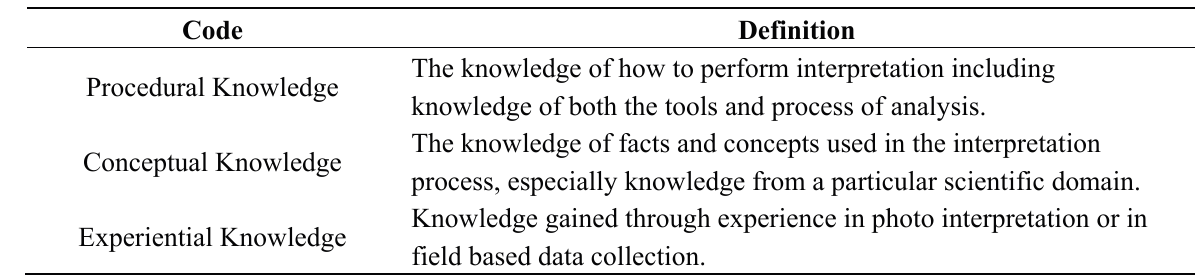
Table 2. Set of Knowledge Codes used in this Content